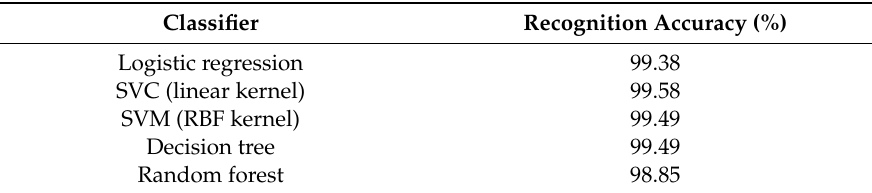
Table 7. Model performance at different classifiers.